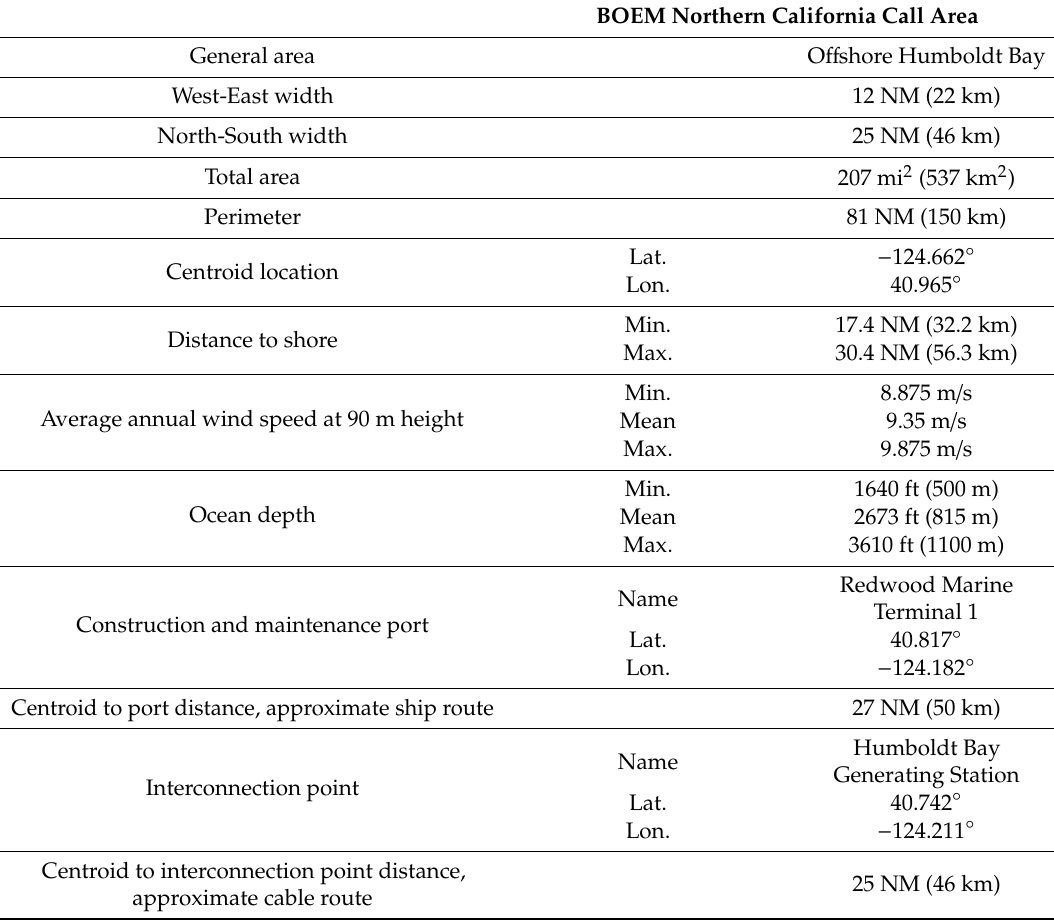
Table A2. Geographic specifications of study